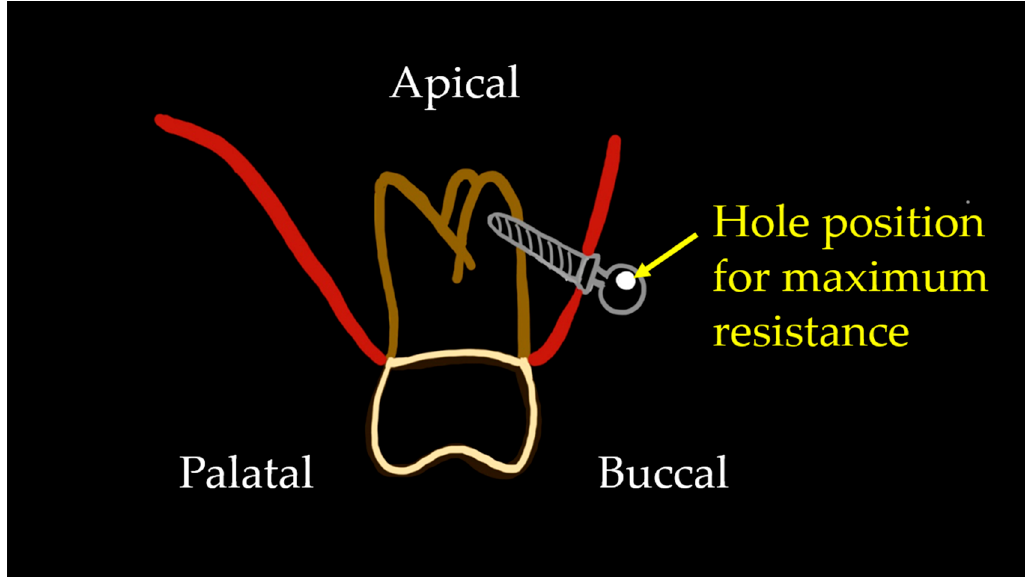
Figure 10. Suggestion of an ideal head hole position for maximum resistance to counter-clockwise rotational force. When the miniscrew tip directed the apical side with an angulation to the alveolar bone surface, the hole positioned on the upper (apical) side of the head would generate the maximum resistance to the rotational